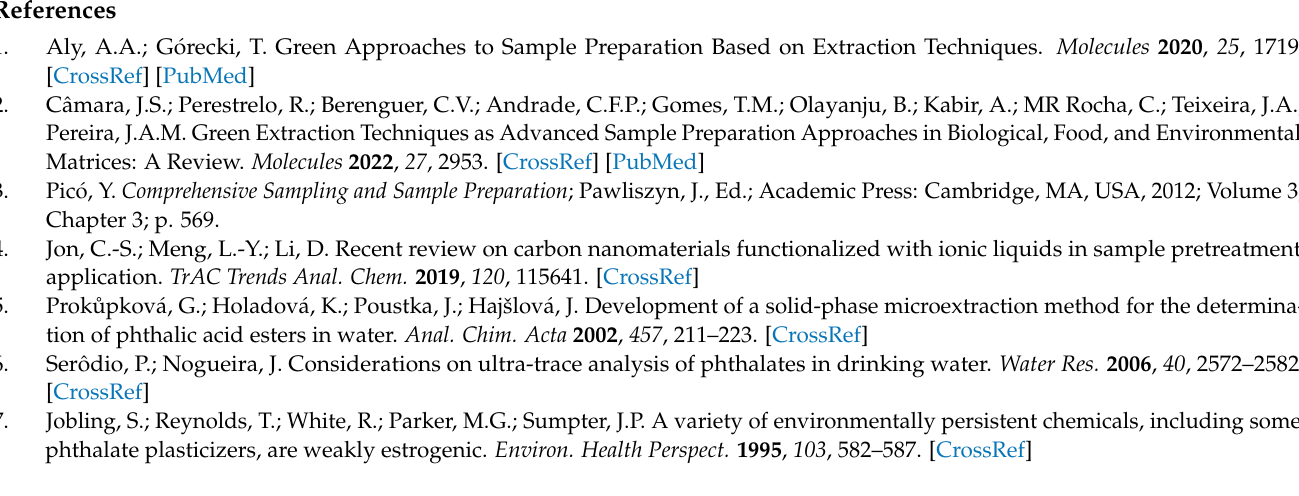
applied desorption time on the peak area of target analytes; Figure S9. Thermogravimetric analysis curve of MWCNT–IL/PANI adsorbent; Figure S10: AFM images of MWCNTs IL/PANI